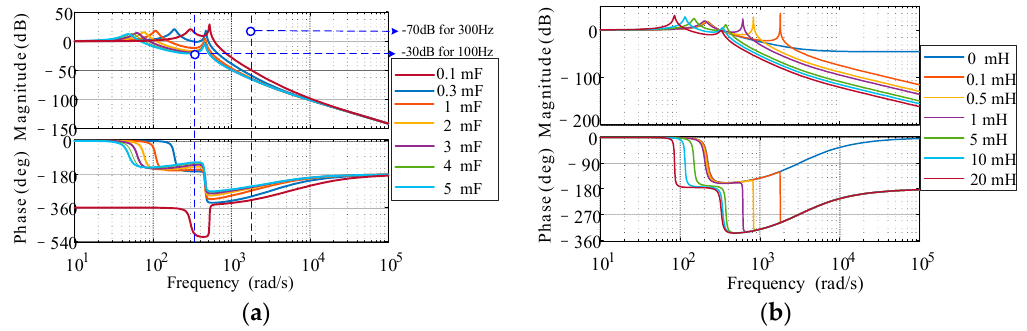
Figure 10. Effect of filter parameters on voltage transfer characteristics: ( a ) C 1 change and ( b ) L 1 change.